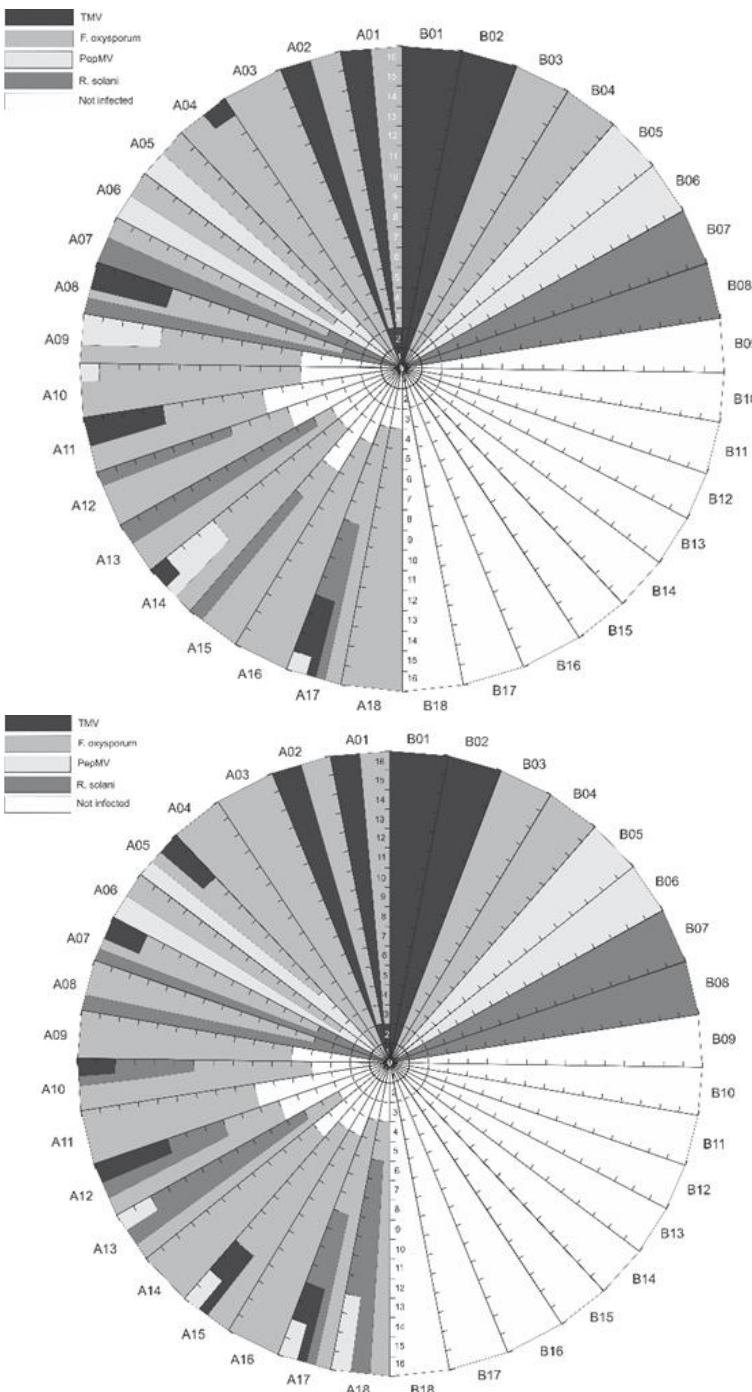
Figure 2. Dispersal of F. oxysporum , R. solani, TMV, PepMV and infection of tomato plants in an NFT system within a 16-week survey dependent on a sanitizing treatment of the recirculating fertigation solution. Non-infected plants (A09 to A18 and B09 to B18) and those initially infected with either F. oxysporum (A03, A04, B03 and B04), R. solani (A07, A08, B07 and B08), TMV (A01, A02, B01 and B02), or PepMV- (plant A05, A06, B05 and B06) are cultivated in flat channels with recirculating fertigation solution flow. Plants with the letter A are provided with untreated fertigation solution, those with the letter B with treated (0.5 mg KClO/L for 60 min a week at pH 6.0 and ORP 780 mV). All plants were tested weekly for an infection with the various pathogens. A thin black line marks the time when the respective pathogen was first detected in a particular plant. Survey 1 (top) and Survey 2 (below).